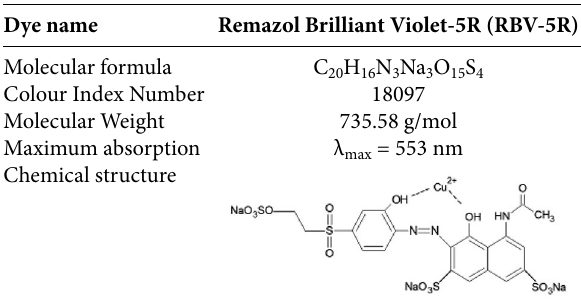
Table 1. Properties of the studied RBV-5R textile